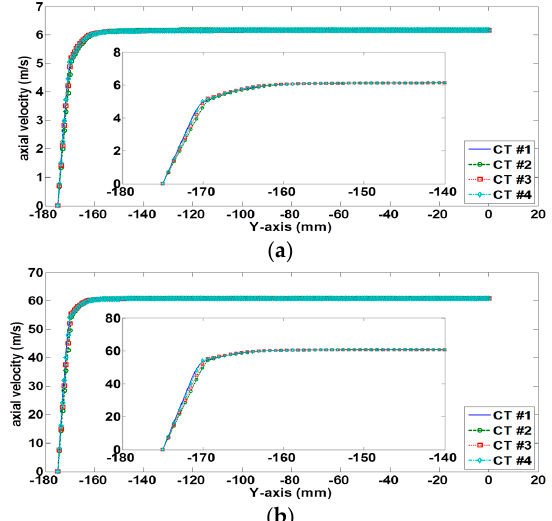
Figure 10. Axial velocity profiles at the octagonal cross-sectional contraction exits, ( a ) V ex = 6 m/s; ( b ) V ex = 60 m/s.